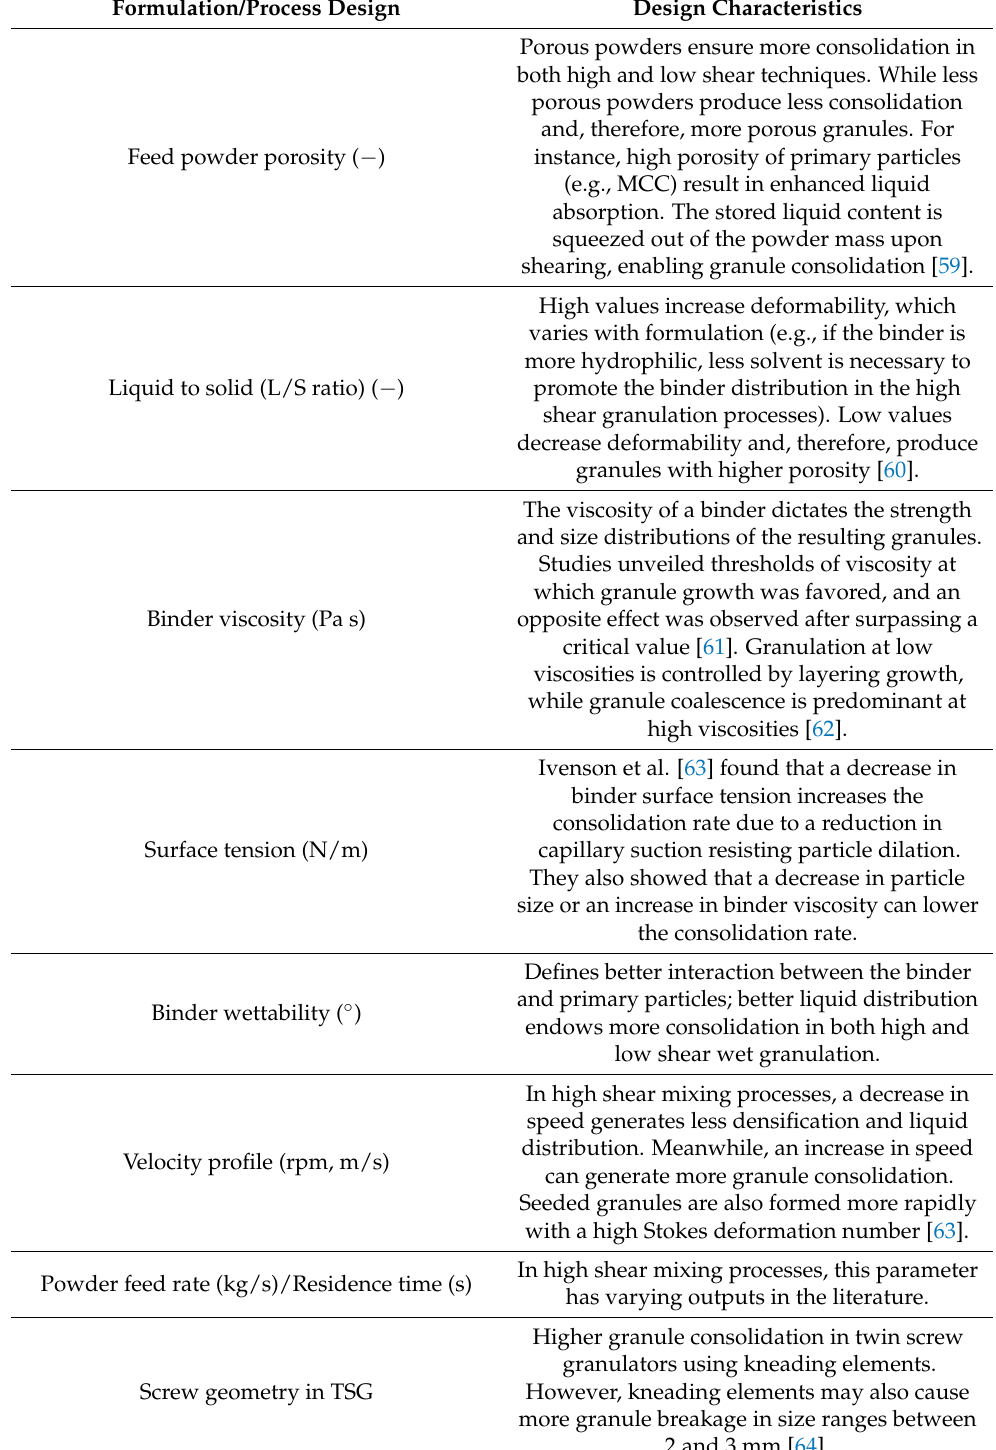
Table 4. General process design targeting granule growth and consolidation regimes for high shear wet granulation (high shear mixing and twin-screw